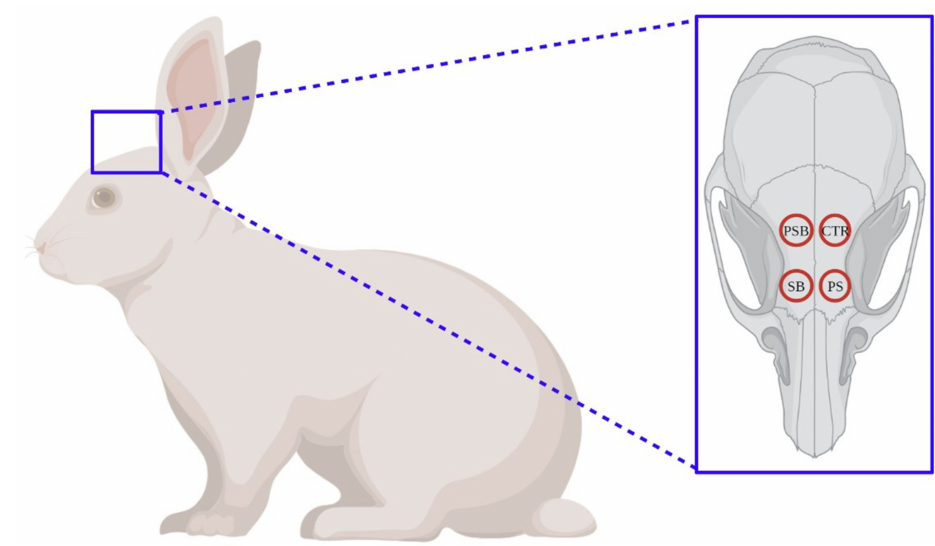
Figure 1. Distribution of study groups in parietal bone defects.